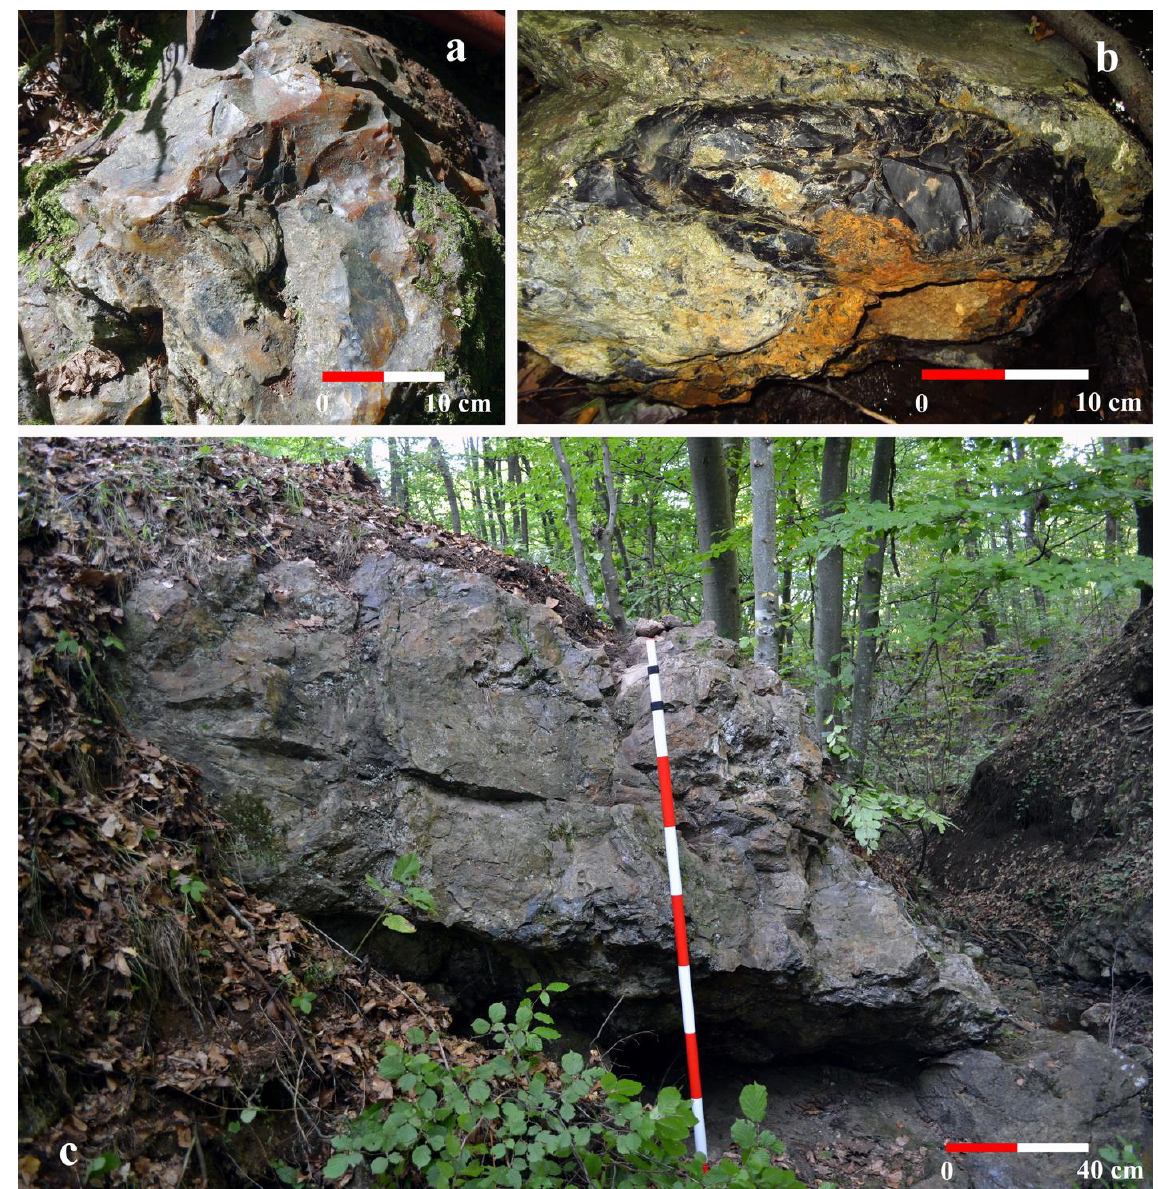
Figure 4. Kremenjak Stream: a) traces of exploitation (detail); b) example of black opal extraction; c) rock of opal in the stream